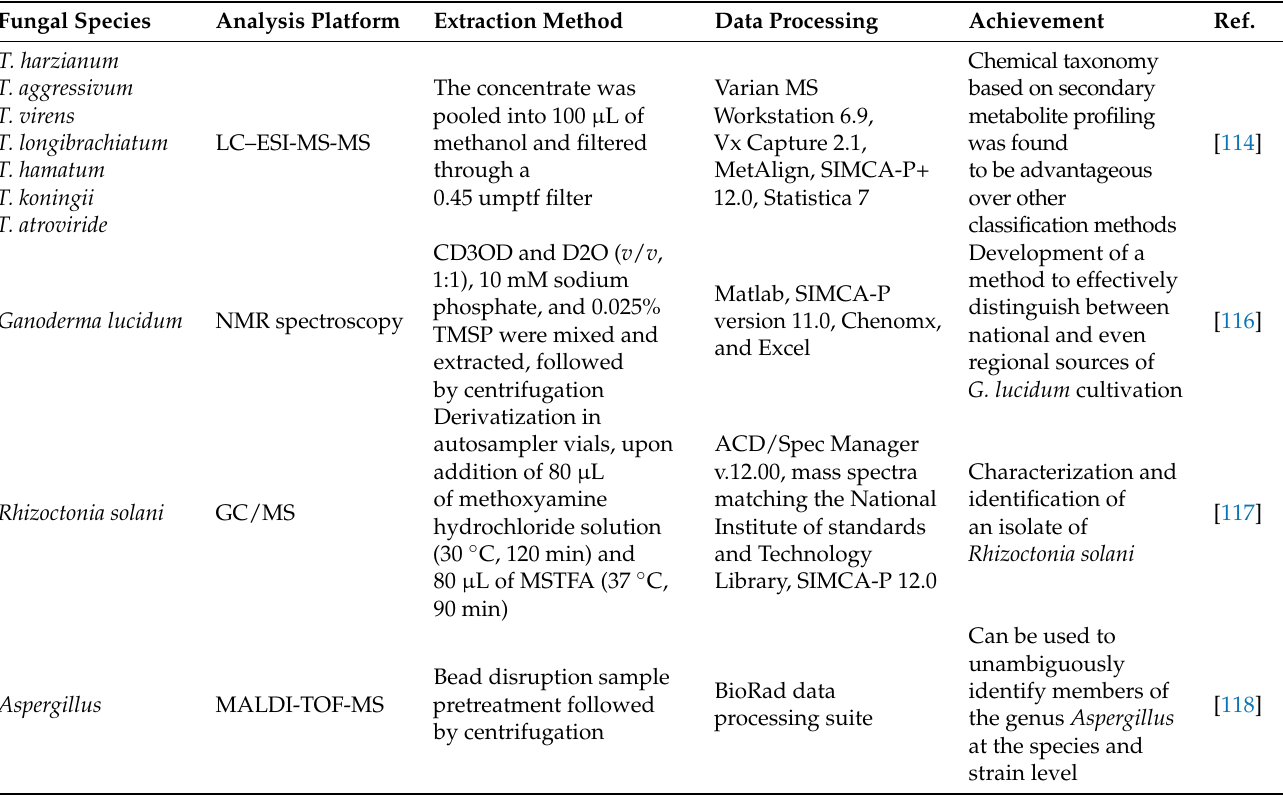
Table 2. Metabolomics for taxonomic identification of